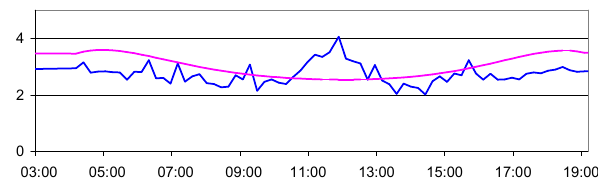
Figure 13. Measured O 4 AMF (blue, after normalisation) for 15 June 2009. The magenta curve represents the SZA-dependent